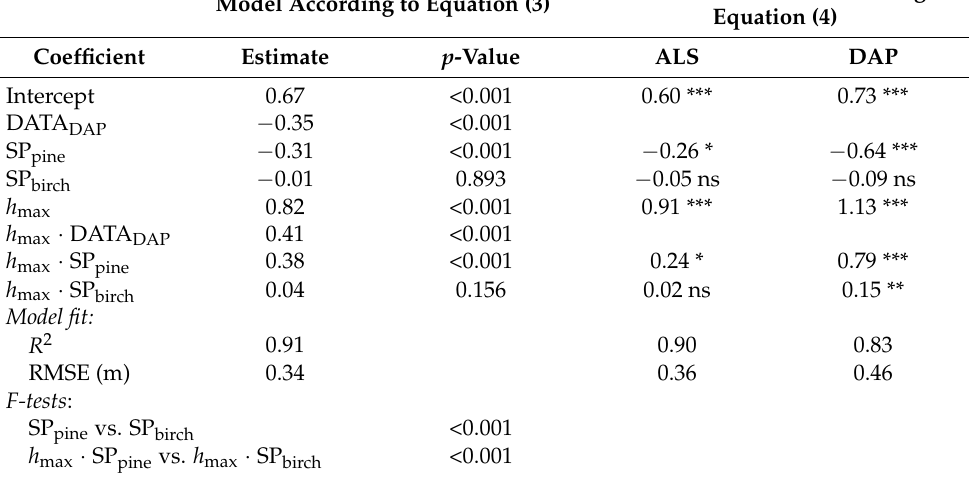
Table 8. Estimation results for regression models shown in Equations (3) ( n = 2 × 389) and Equation (4) ( n = 389). Estimates for Models According to Model According to Equation (3) Equation